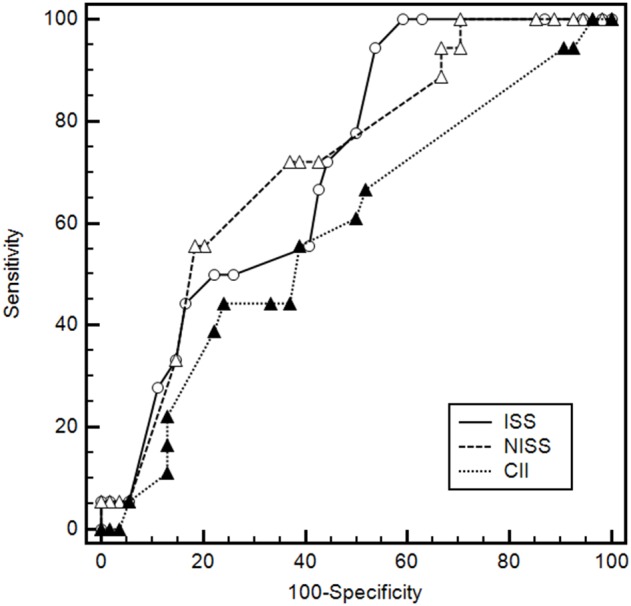
Receiver operating characteristic (ROC) curves of different trauma scoring systems for predicting respiratory failure in patients admitted to our hospital in the Lushan earthquake.The solid line indicates the ROC curve for the Injury Severity Score (ISS); the dashed line, the curve for the New Injury Severity Score (NISS); and the dotted line, the curve for the Chest Injury Index (CII) [4].